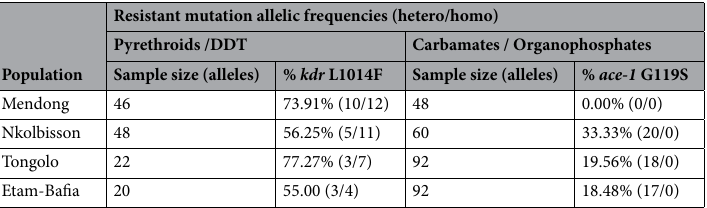
Table 2. Distribution of the kdr L1014F and ace-1 G119S alleles in different Culex quinquefasciatus populations from the city of Yaoundé.